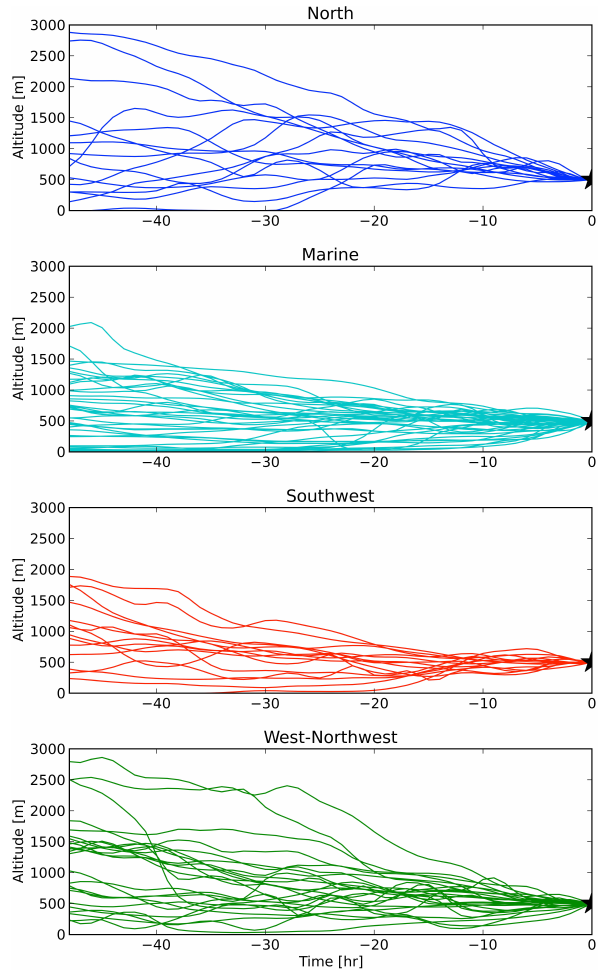
Fig. 3. HYSPLIT 2-day air mass back trajectory vertical profiles initialised twice per day at 08:00UTC and